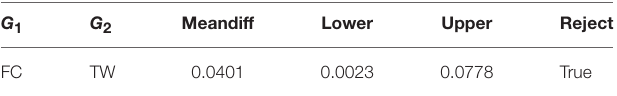
TABLE 8 | The influence of data source through multiple comparison of means - Tukey HSD, FWER=0.05.